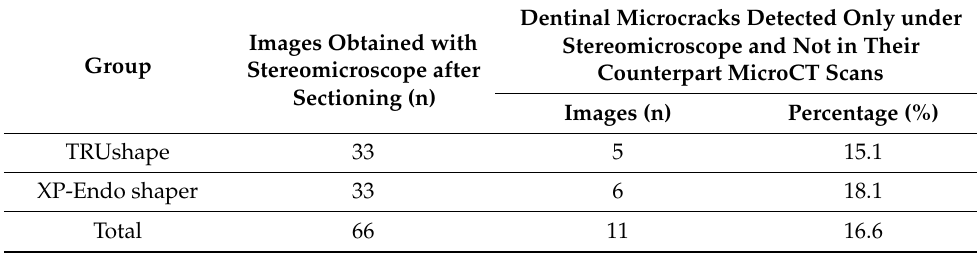
Table 2. Frequency of dentinal microcracks only detected after sectioning and examination under stereomicroscope.